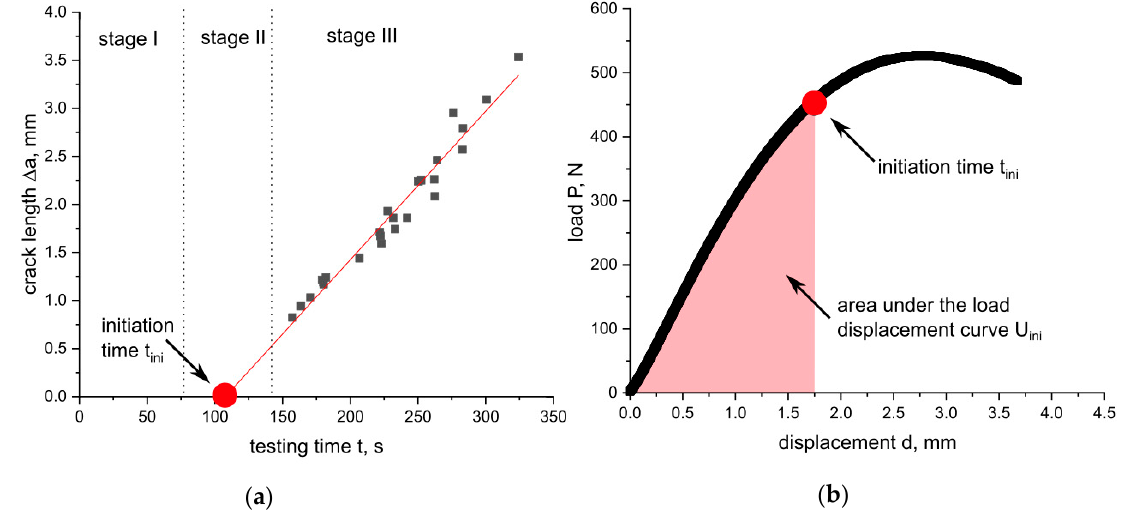
Figure 4. Crack propagation kinetics for the estimation of the initiation time t ini ( a ) and evaluation of U ini (area under the load displacement curve up to t ini ) ( b ).